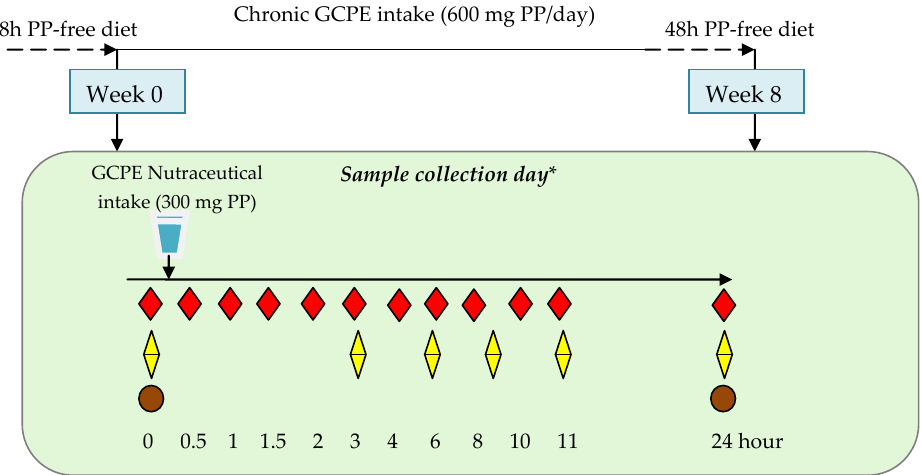
Figure 1. Schematic view of the study and collection of blood, urine, and fecal samples. * On each sampling day, volunteers consumed a single dose of the GCPE nutraceutical dissolved in water. GCPE: green coffee phenolic extract; PP: (poly)phenols.